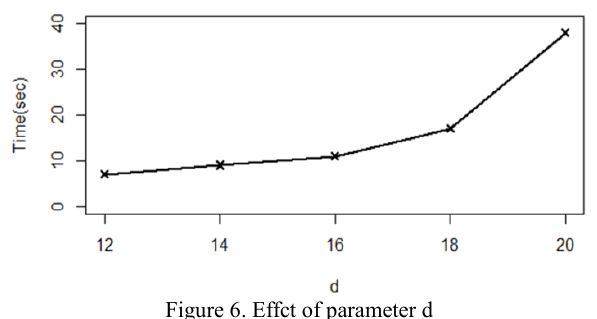
Figure 6. Effct of parameter